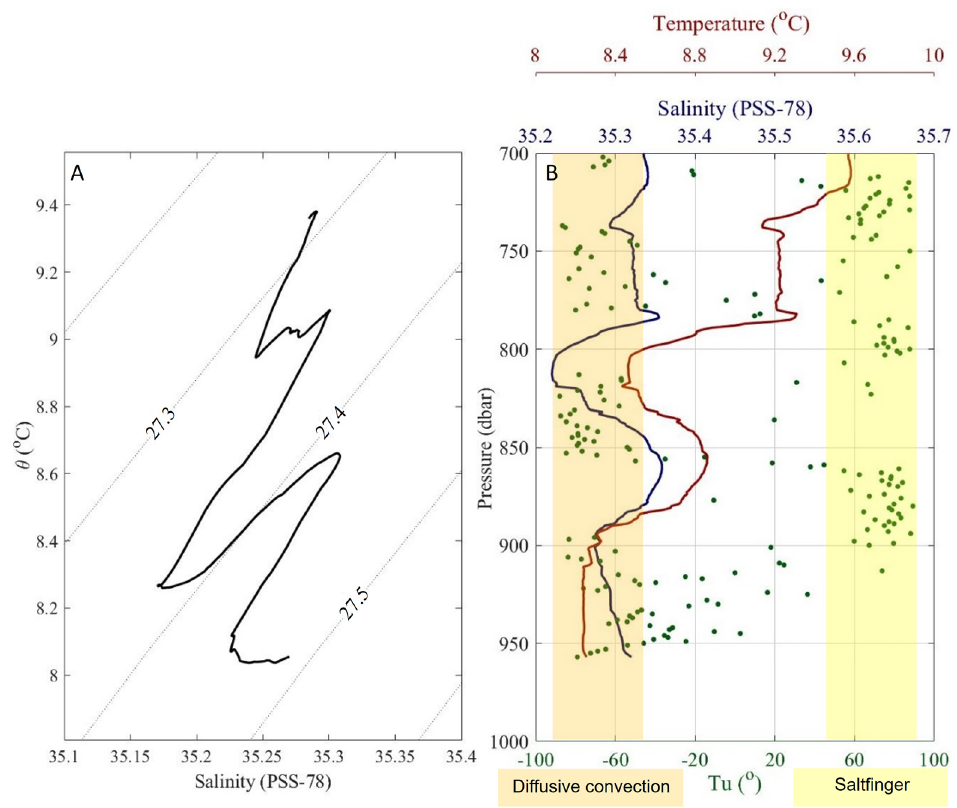
Figure 8. ( A ) θ –S plot for profile number 154 made by the glider in depths from 700 m to 954 m. ( B ) Temperature, salinity and Tu profiles, shown in red, blue and green, respectively. The orange and yellow shades indicate the Tu ranges for diffusive convection and saltfingering.